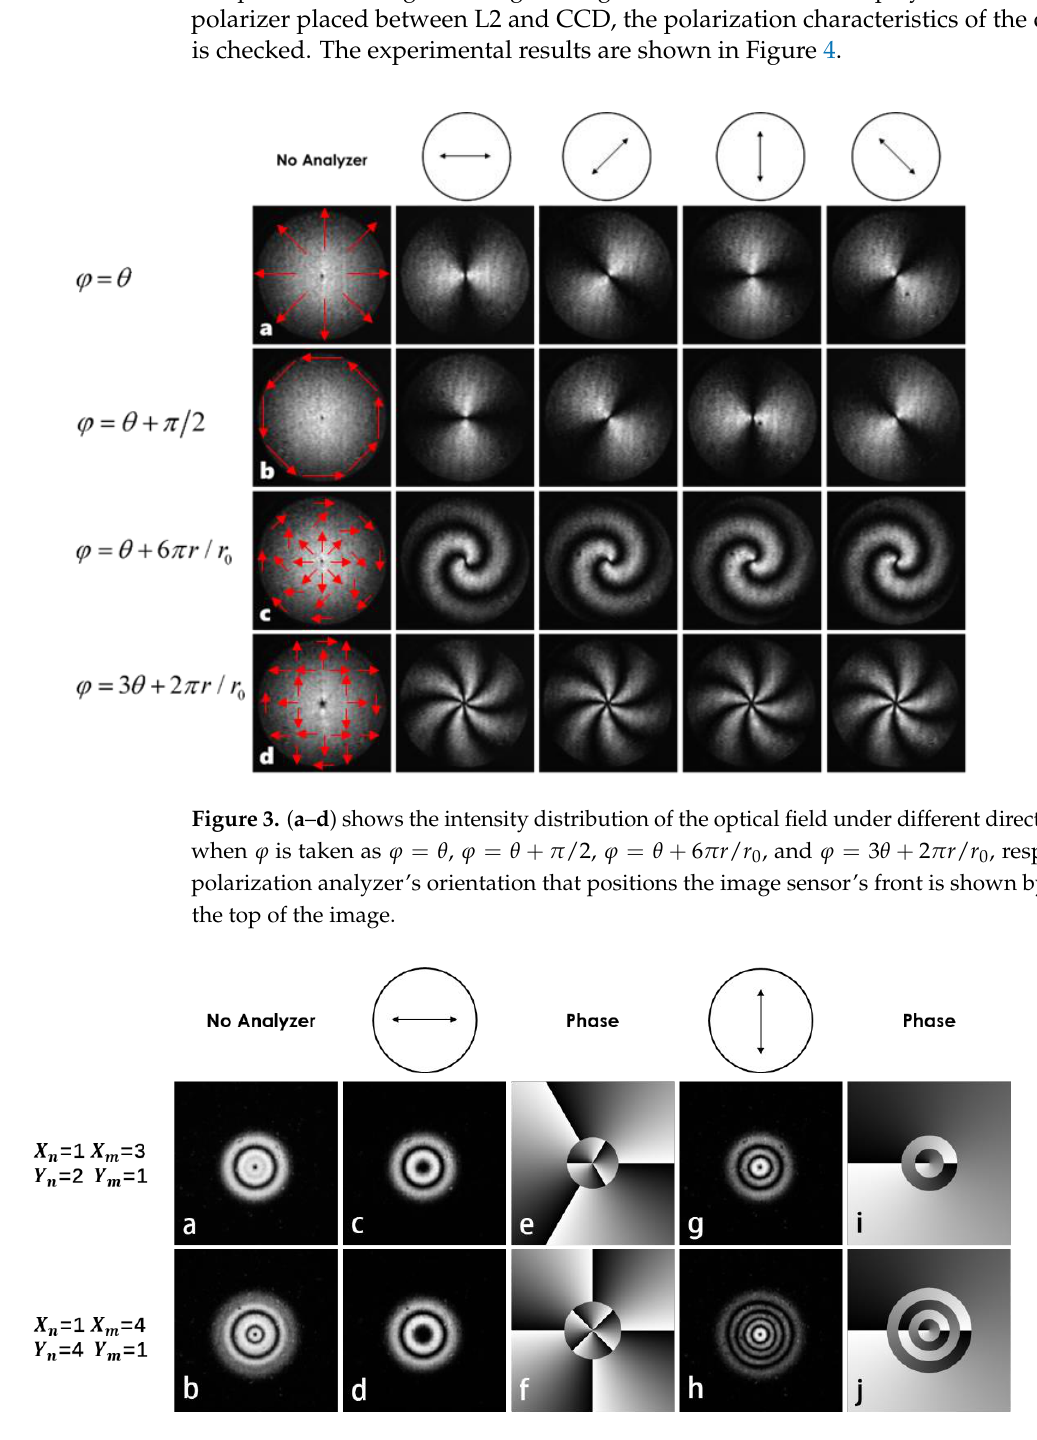
Figure 4. ( a , b ) is the intensity distribution without a polarizer. ( c , d ) shows the optical field intensity distribution under horizontal polarization. ( e , f ) is the corresponding phase distribution. ( g , h ) shows the intensity distribution under vertical polarization conditions. ( i , j ) is the corresponding phase dis- tribution.